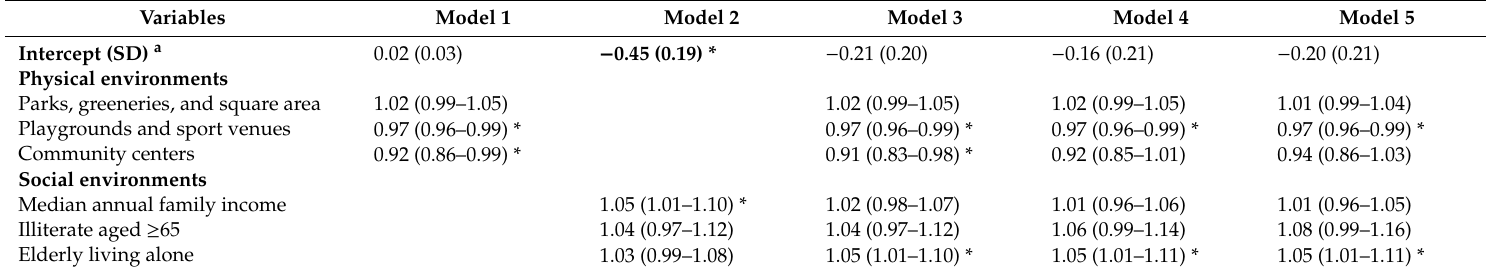
Table 4. Odds ratio of Alzheimer’s dementia in relation to individual characteristics and environmental features # in the residential township of the study